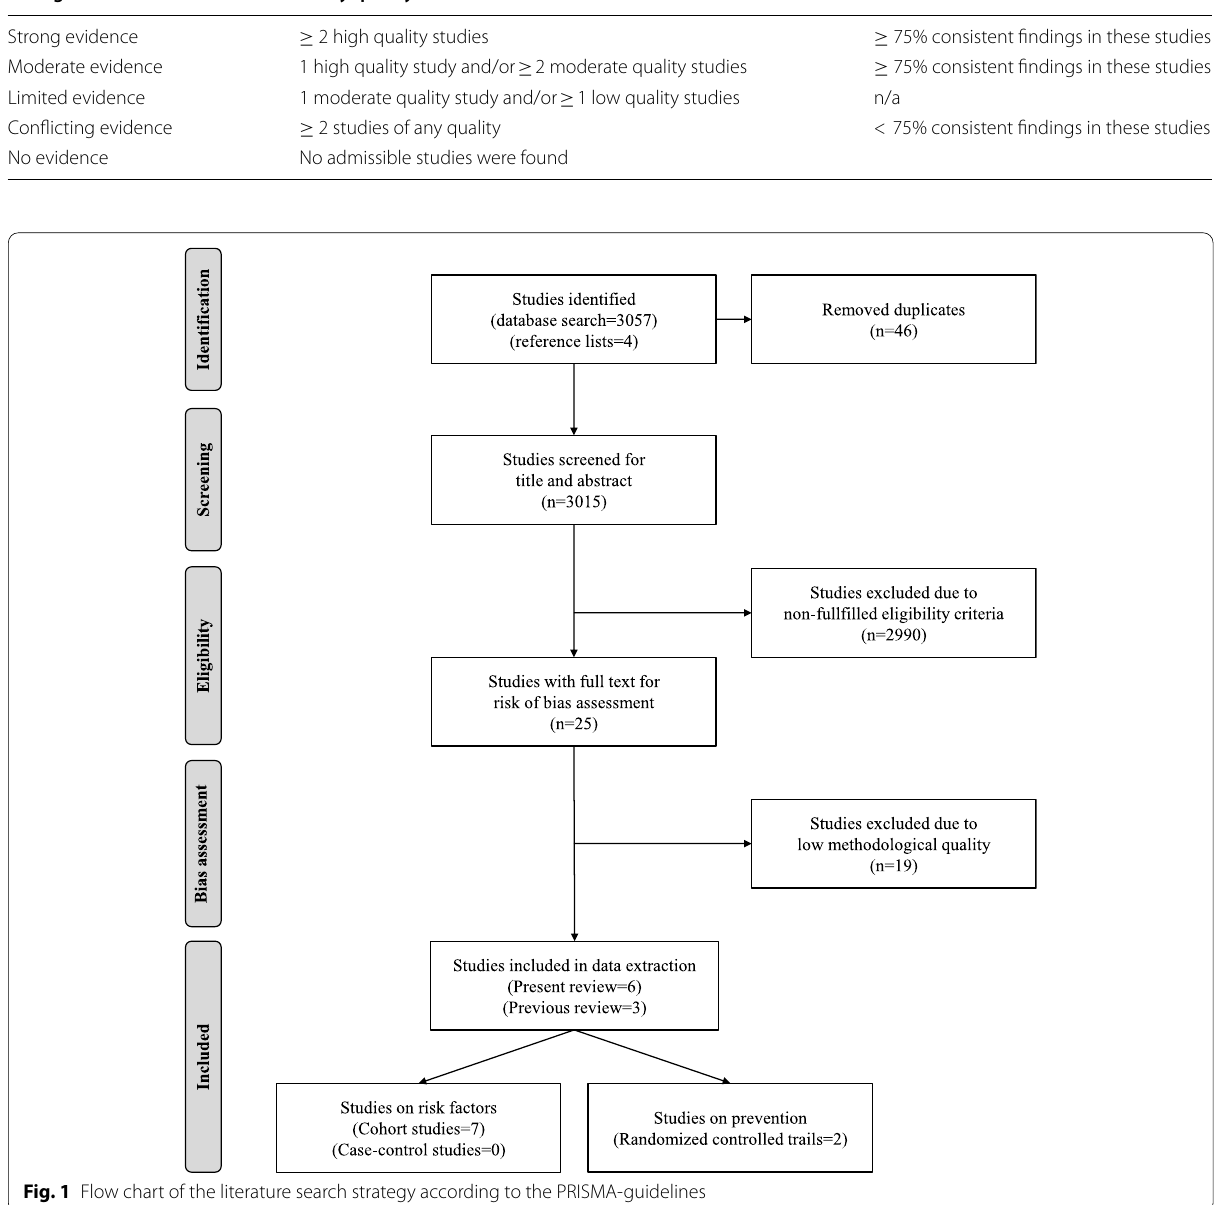
Fig. 1 Flow chart of the literature search strategy according to the